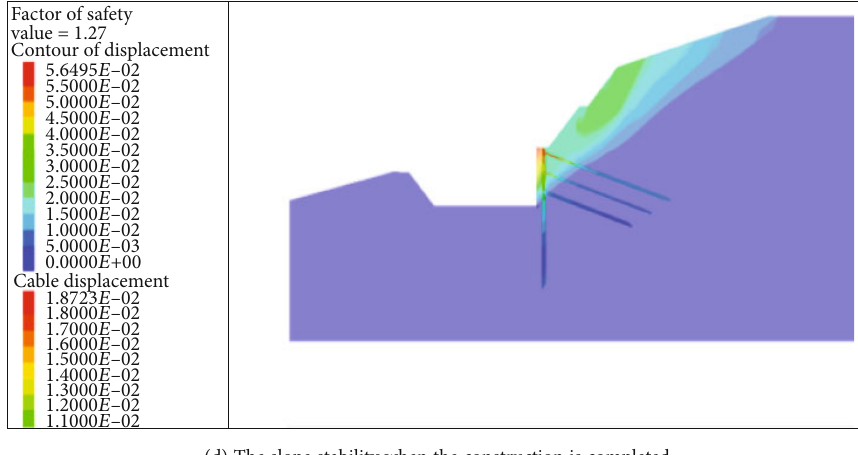
Figure 12: Numerical simulation of suggested rational construction